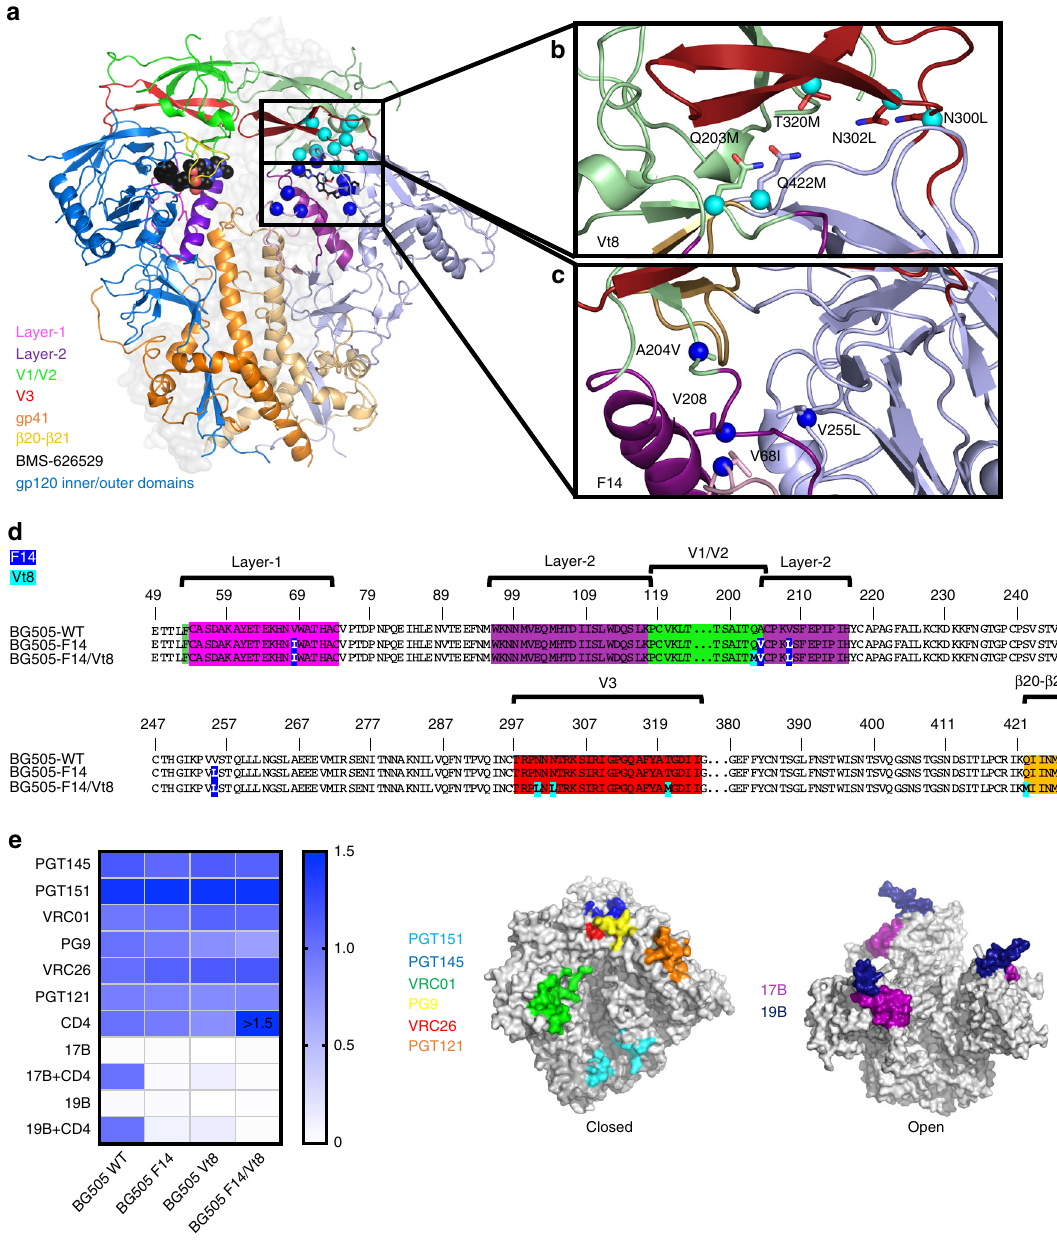
Fig. 1 Disrupting HIV-1 Env allostery to block CD4-induced conformational changes. a HIV-1 Env SOSIP structure. Protomer to the left colored according to regions of allosteric control with BMS-626529 represented as black spheres. Protomer to the right in matte color scheme depicting the location of Vt- series mutations (cyan spheres) and F-series mutations (blue spheres). BMS-626529 depicted in stick representation. b Set of Vt8 residues. c Set of F14 mutations. Residue sidechains are represented as sticks with C α atoms represented as cyan spheres. d Sequence alignment of BG505, F14, and F14/Vt8 with F14 mutations highlighted in blue and Vt8 mutations highlighted in cyan. Layers 1 and 2, the V1/V2 region, and β 20- β 21 are highlighted using the same color scheme as in a . e Binding antigenicity of BG505 SOSIP.664 and mutants. (left) Heatmap of bnAb binding responses, CD4 binding, and CD4 triggering. Values for CD4 binding and CD4 triggering are normalized to BG505 SOSIP. (middle) Surface representation of a closed state SOSIP (PDB ID 5CEZ) and (right) an open state structure (PDB ID 5VN3). Colors identify antibody binding